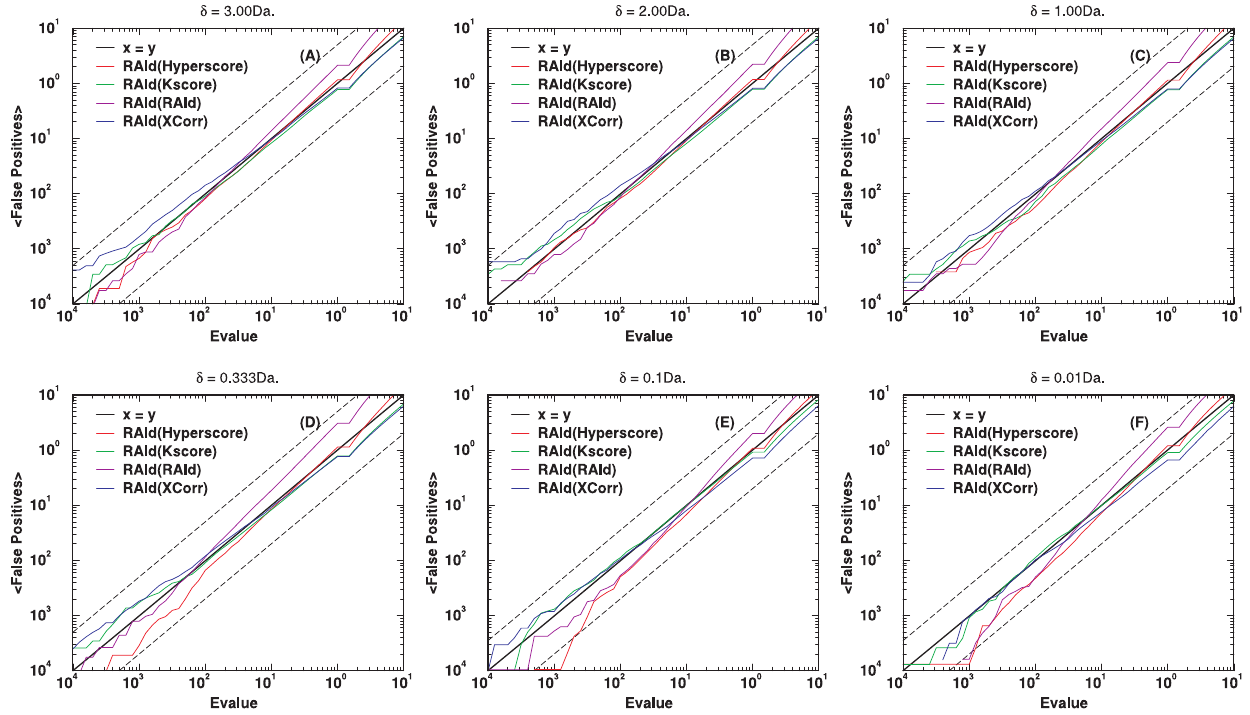
Figure 5. E-value accuracy assessment. The agreement between the reported E -value and the textbook definition is examined using centroid data (A1–A4 subsets of ISB data set). The random database size used is 500 MB. The molecular weight range considered while searching the database is ½ MW { d , MW z d (cid:2) . In each panel, the dashed lines, corresponding to x ~ 5 y and x ~ y = 5 , are used to provide a visual guide regarding how close/ off the experimental curves are from the theoretical curve.